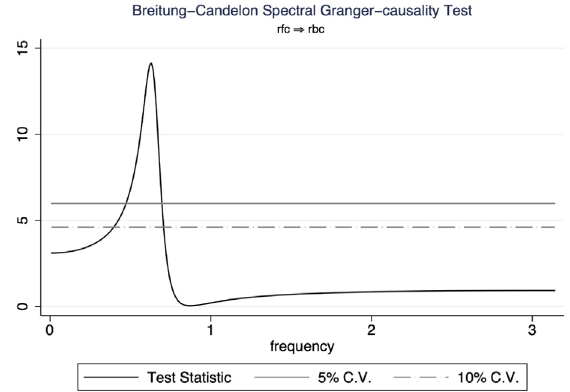
Figure 4. Spectral Granger causality test for financial cycles impact on business cycles in the UK 1270–2016 (source: authors’